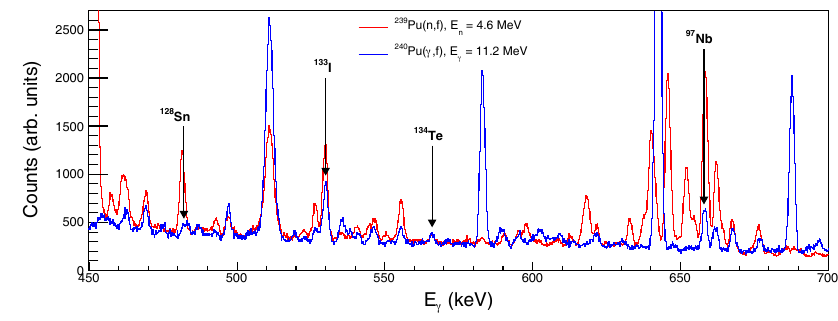
Figure 1. γ -ray spectra from fission products from 240 Pu( γ ,f) at E γ = 11 . 2 MeV and 239 Pu(n,f) at E n = 4 . 6 MeV, measured by a 60% relative e ffi ciency HPGe. Both spectra come from targets which were irradiated for 2